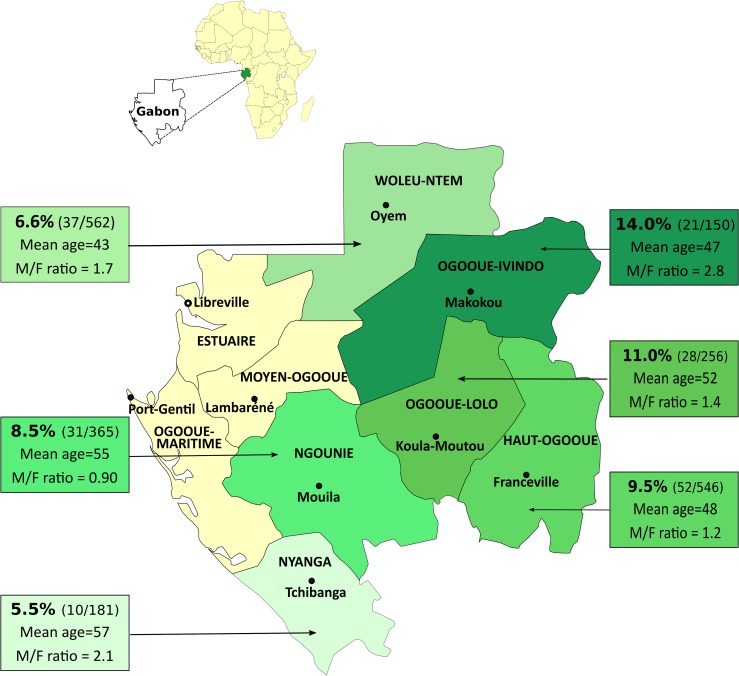
Prevalence of HTLV-1 according to the geographical distribution of the six provinces studied in Gabon.The data given in the figure indicate, for each province, the HTLV-1 prevalence, the number of positive individuals among those tested, the mean age and the sex ratio. This map was modified from https://commons.wikimedia.org/wiki/Atlas_of_Gabon using Inkscape 0.92.2.